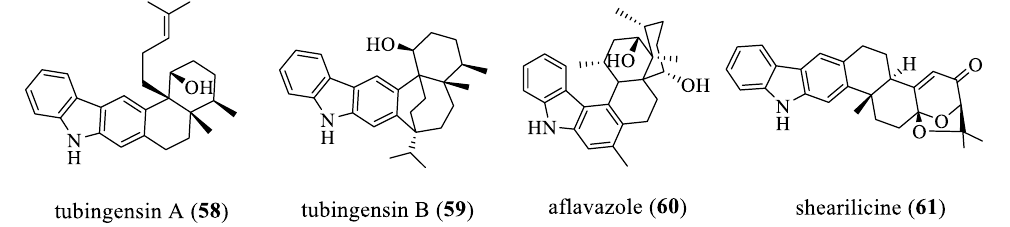
Fig. 5 Chemical structures of tubingensin A series